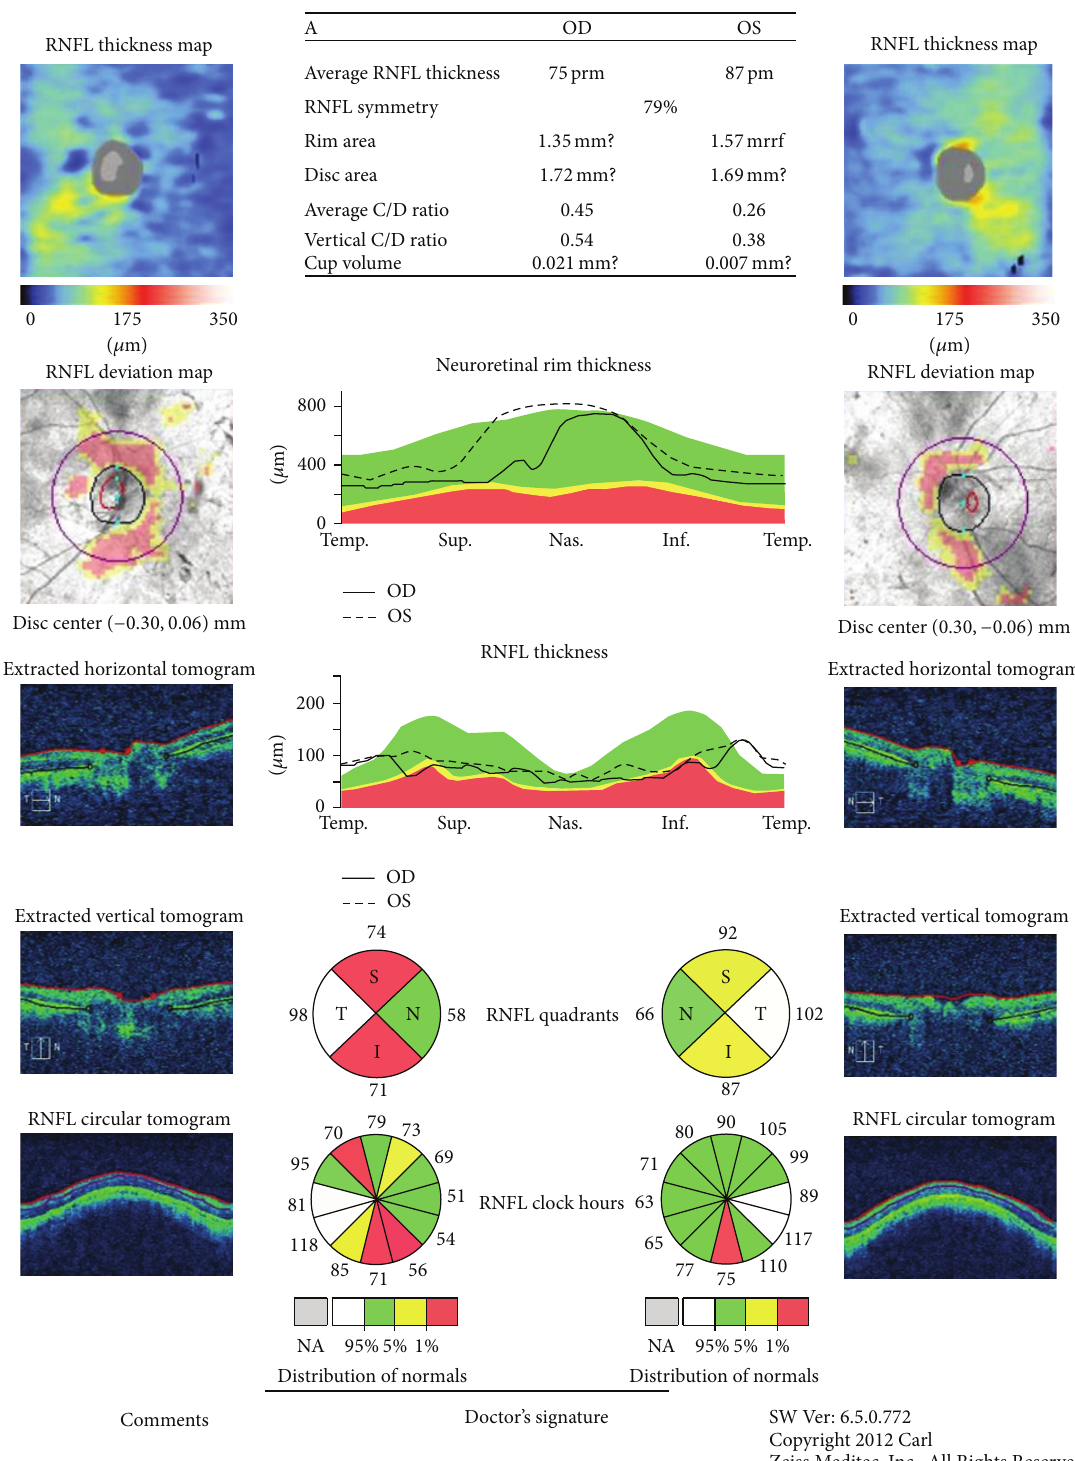
Figure 1: Retinal nerve fiber layer analysis in patients with retinitis